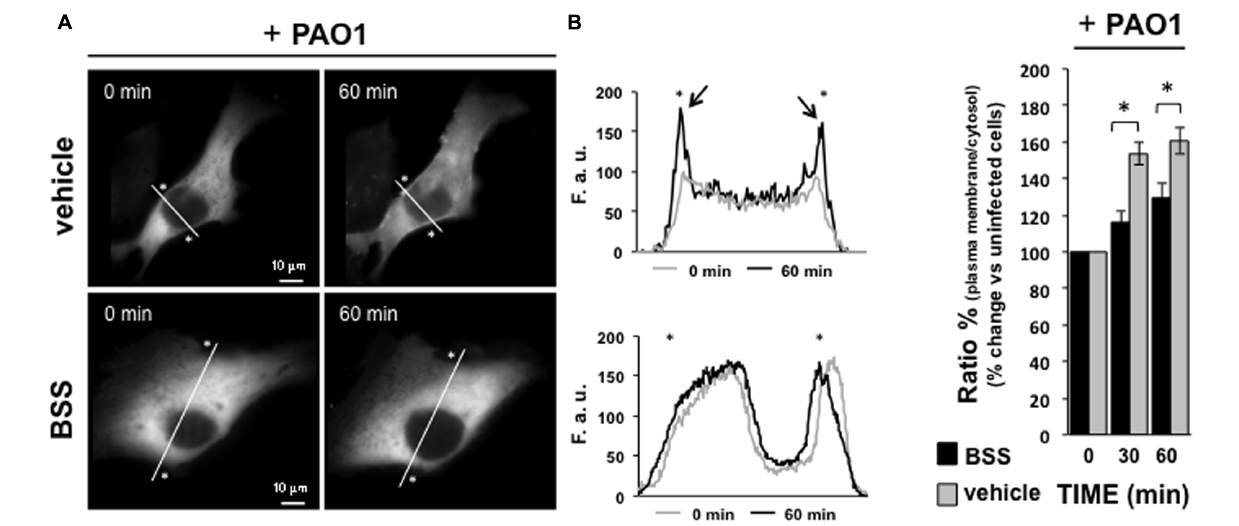
FIGURE 7 | Effect of BSS on PKC α translocation. IB3-1 cells were seeded and then transfected with the Protein Kinase C isoform α fused to green fluorescence protein (PKC α GFP). Microscope analysis was performed 36 h after transfection, P. aeruginosa strain 1:100 CFU was added to the cells, as shown in the figure. (A) Images of PKC α translocation on the plasma membrane in the presence of P. aeruginosa strain PAO1 in cells pre-treated with BSS or solvent alone (vehicle). PKC α translocation was quantified by using line scan profile of fluorescence intensity across the cell, indicated by white diagonal lines in “0 min” and “60 min” images. The graphs show the comparison between the PKC α GFP fluorescence intensity profiles, expressed as fluorescent arbitrary units (F.a.u.), at 0 min and 60 min of PAO1 infection in cells pre-treated with vehicle and BSS, respectively. The asterisks indicate the edge of the cell indicative of plasma membrane. The arrows designate the enriched PKC α GFP signal at the plasma membrane in cells pre-treated with vehicle after 60 min of pathogen infection, confirming the plasma membrane translocation of PKC α GFP. (B) The recruitment of the kinase is expressed as percentage of the increase in fluorescence ratio with respect to time 0 of pathogen infection, calculated as the ratio of plasma membrane and cytosol average intracellular fluorescence intensity, obtained from multiple regions inside the cytosol and on the cell membrane, measured on single cell. The values are expressed as fold change vs. un-infected PAO-1 control cells (0 min), referred as 100%.